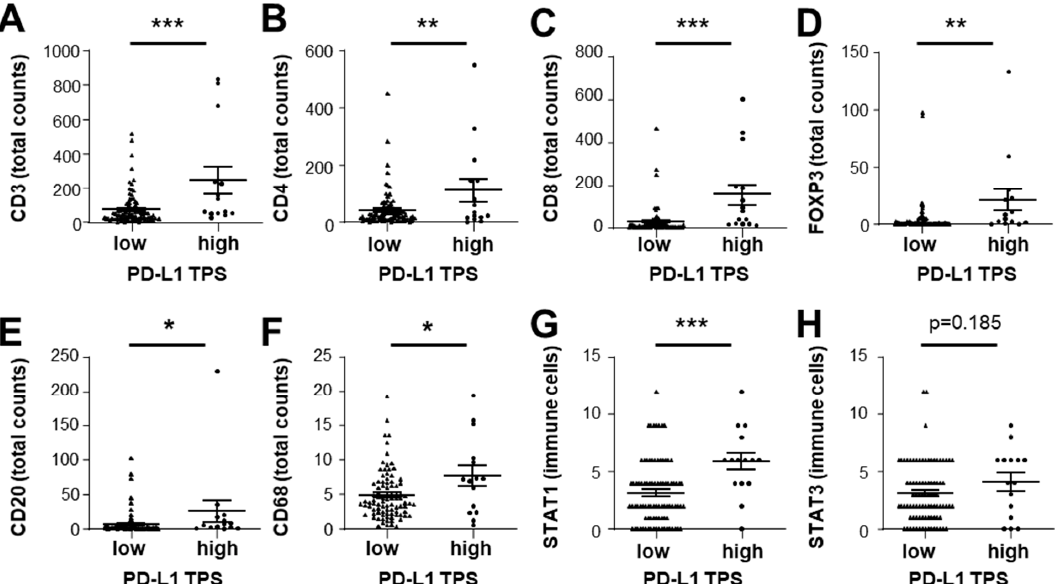
Figure 5. Association between PD-L1 expression in the tumor epithelium and immune cell infiltration in HCC tumor samples. ( A ) CD3-, ( B ) CD4-, ( C ) CD8-, ( D ) FOXP3-, ( E ) CD20-, ( F ) CD68-, ( G ) STAT1-, and ( H ) STAT3-positive immune cell infiltrate in HCC tumor tissue samples stratified by low ( N = 90) and high PD-L1 TPS expression score ( N = 15). TPS—tumor proportion score. * p < 0.05; ** p < 0.01; *** p < 0.001.